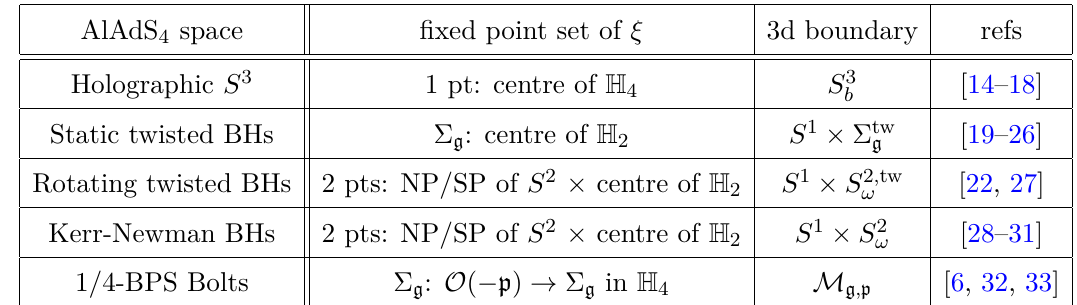
Table 1 . The fixed point set of ξ for a number of (non-singular) supersymmetric asymptotically locally Euclidean AdS (i.e. H ) solutions, and the corresponding three-dimensional holographically 4 4 dual backgrounds. The first entry generically denotes a family of asymptotically Euclidean AdS solutions which consist of various ways one can squash the boundary three-sphere. The suggested references discuss in detail either the 4d bulk background, the 3d partition function, or